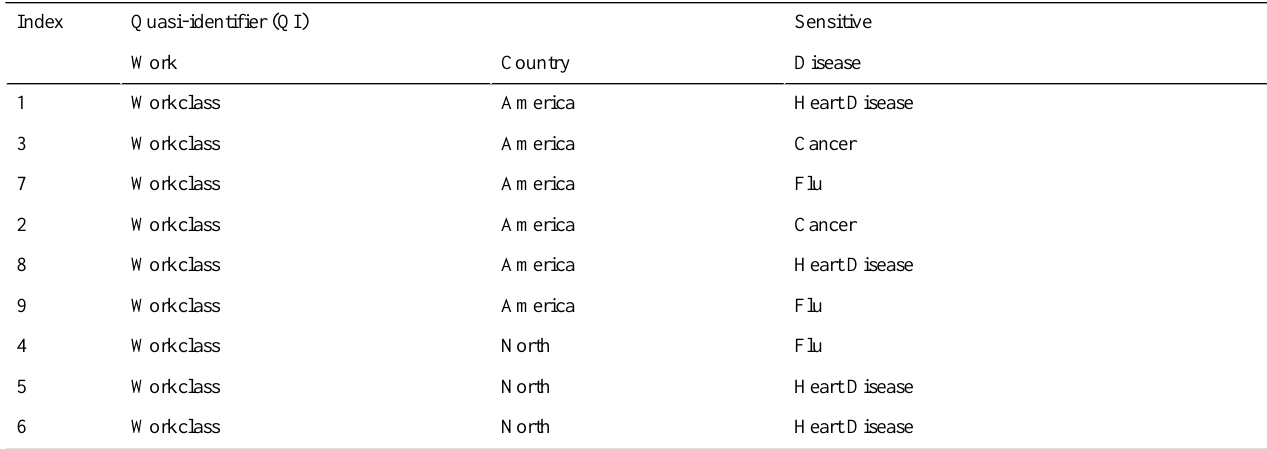
Table 3. An example of a 3-diverse data